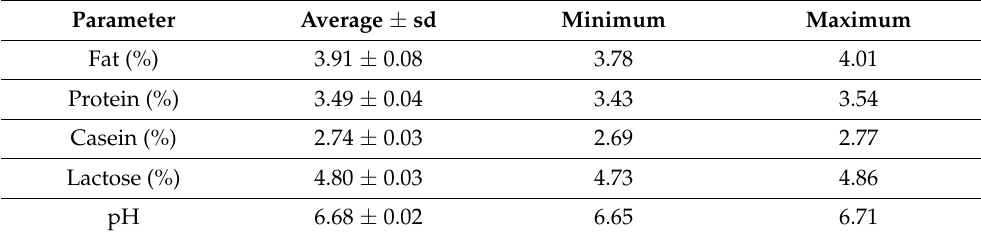
Table 1. Chemical characteristics of raw milk upon arrival at the dairy. Data are expressed as the mean of six repetitions. sd = standard deviation. For each parameter, maximum and minimum are reported.